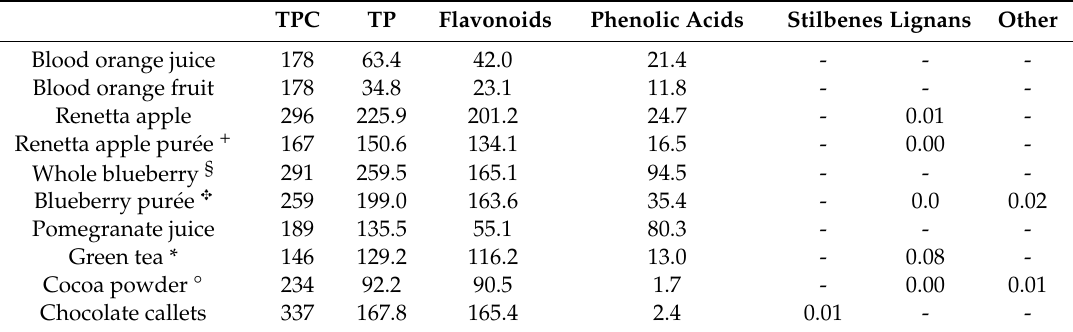
Table 1. Polyphenol content and composition of each serving of MaPLE products included in the dietary intervention, expressed as mg per